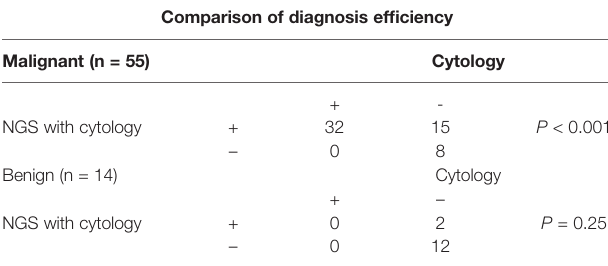
TABLE 4 | Improvement by combining cytology with NGS in diagnosis.